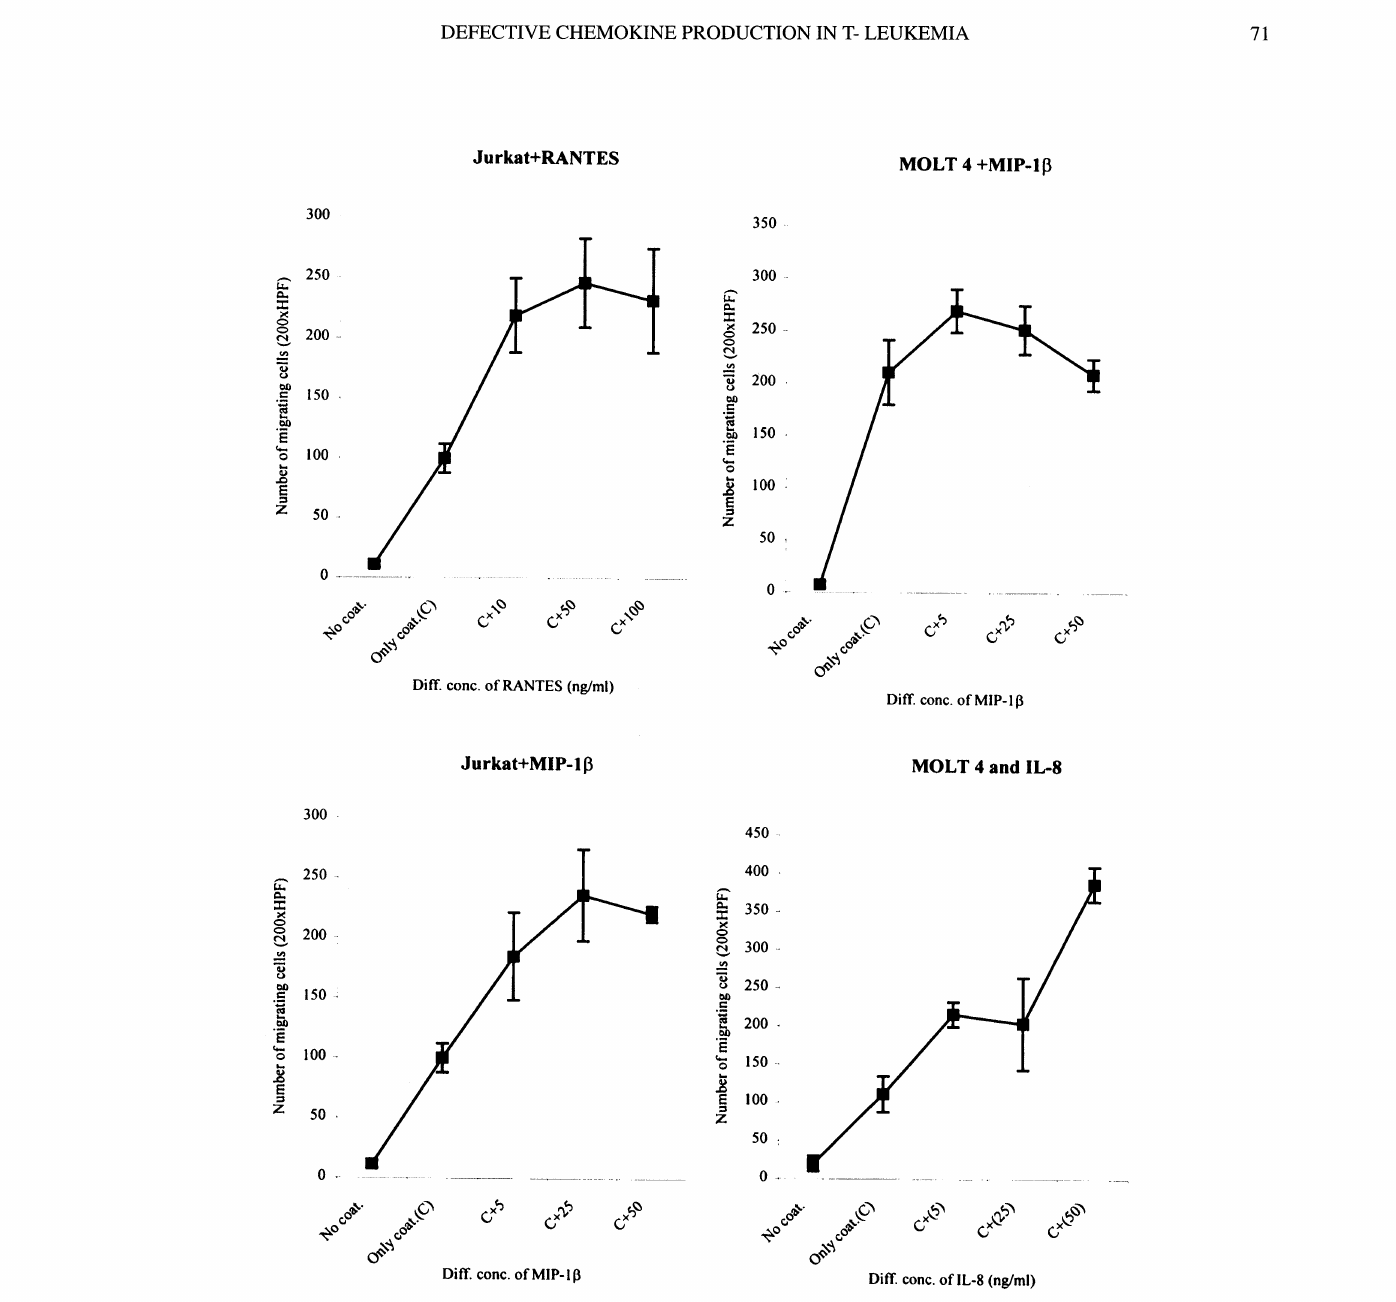
Diff. conc. of IL-8 (ng/ml) Migration of MOLT 4 and Jurkat T-cell lines in Boyden chemotaxis assay through filters coated on the lower surface with fibronectin 20 gg/ml (indicated as coat=C) in the absence and presence of chemokines in the lower well as described in the figure